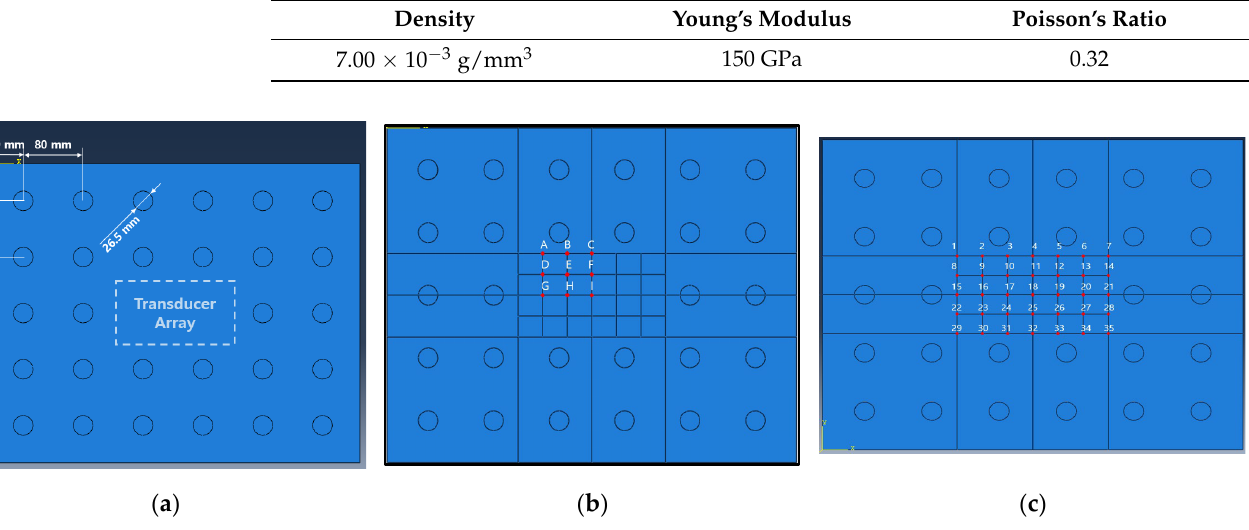
Figure 8. ( a ) Simulated circular defects on aluminum panel; ( b ) candidate excitation locations; ( c ) sensor locations.